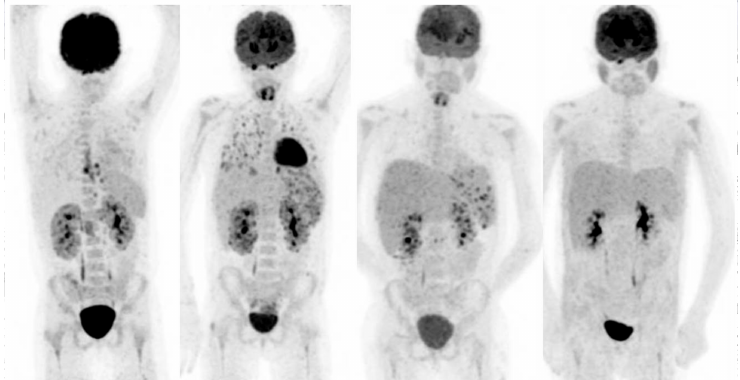
Figure2. 20-year-oldfemale, knownwithrecurrentacutelymphaticleukaemia. Afterfirstchemotherapy cycle fever and neutropenia. Blood cultures: candidia. Left scan: infectious foci around catheter in the oesophagus and heterogeneous uptake in the kidneys. Scan 2, 6 weeks after treatment with fluconazole: progressive disease with now involvement of the lungs, spleen and kidneys. Biopsy of the parenchyma of the right kidney confirmed renal candidiasis. Caspofungin was added to the antifungal treatment. Scan 3, 3 months after treatment with fluconazole and caspofungin: improvement, but still involvement of spleen and kidneys. Treatment continued. Scan 4, after 6 months treatment: no active infection